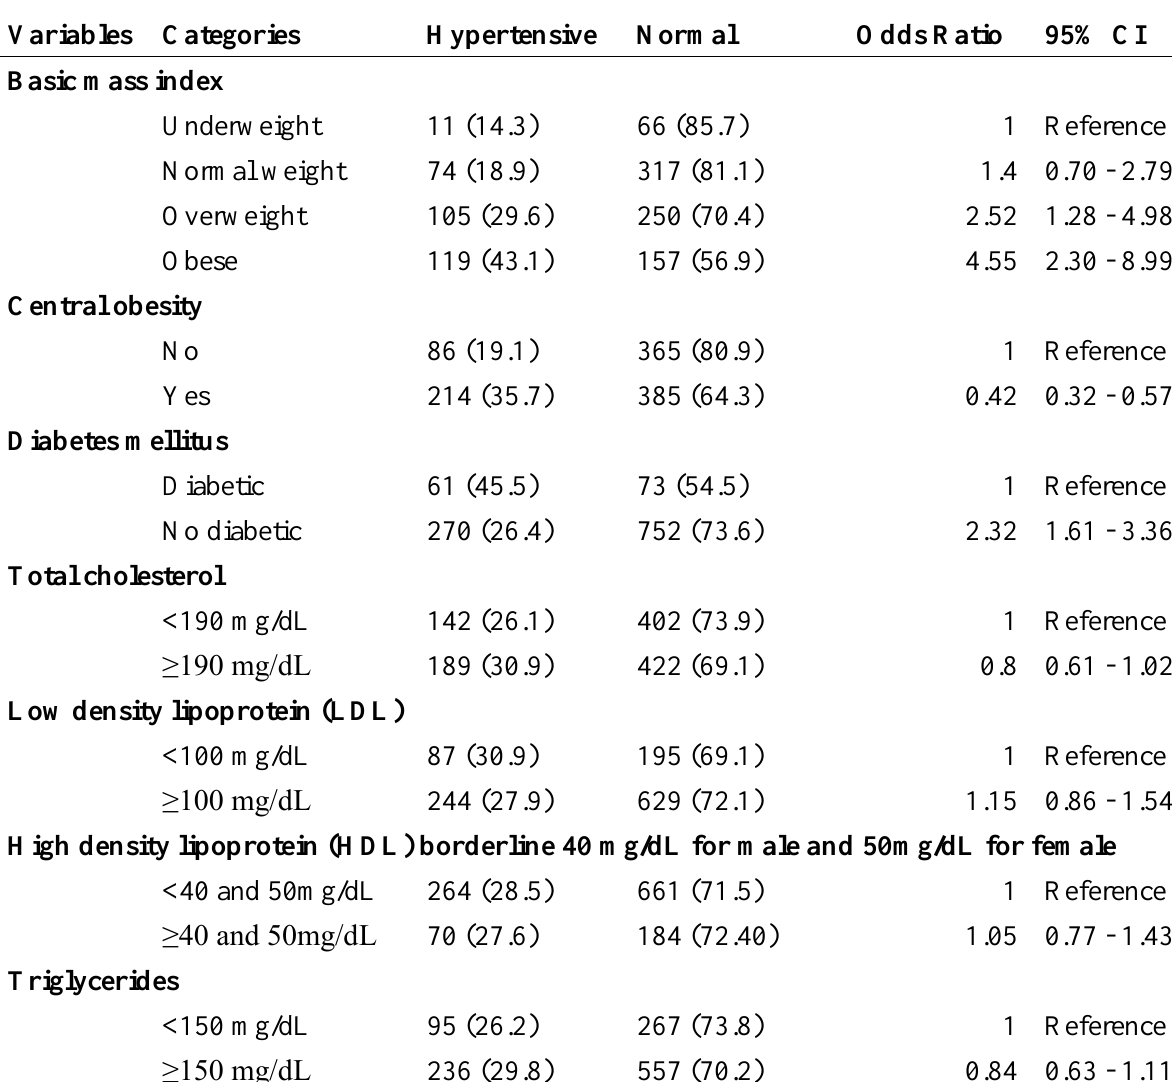
Table 4: Bivariate analysis of pathophysiologic factors and hypertension among those surveyed using the WHO STEPS in Jalalabad, Nangarhar,